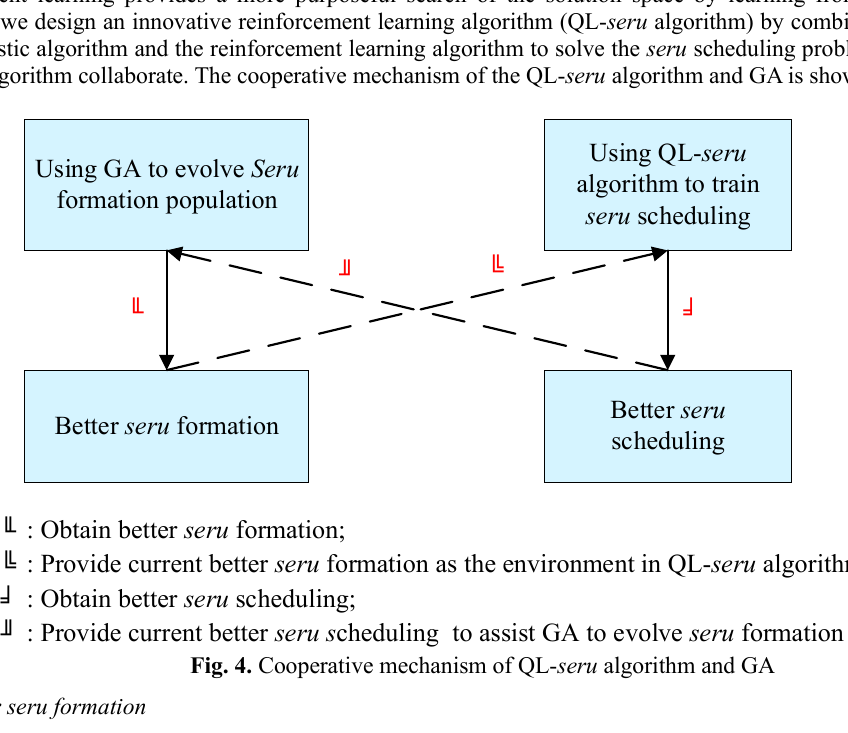
Fig. 4. Cooperative mechanism of QL- seru algorithm and